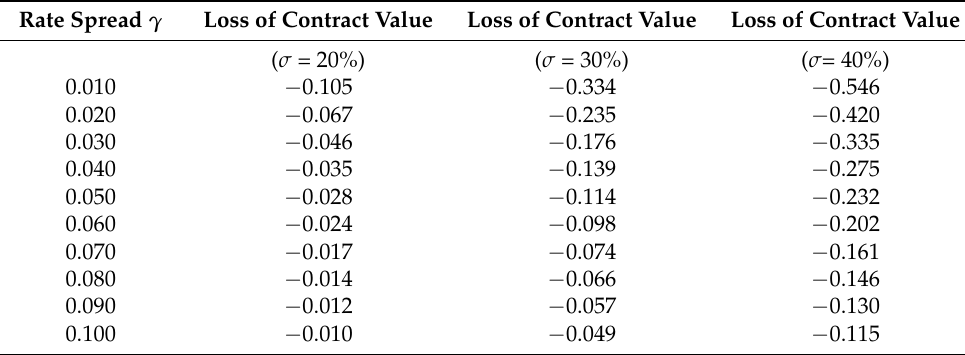
Table 2. Credit risk and the comparative loss in contract value from